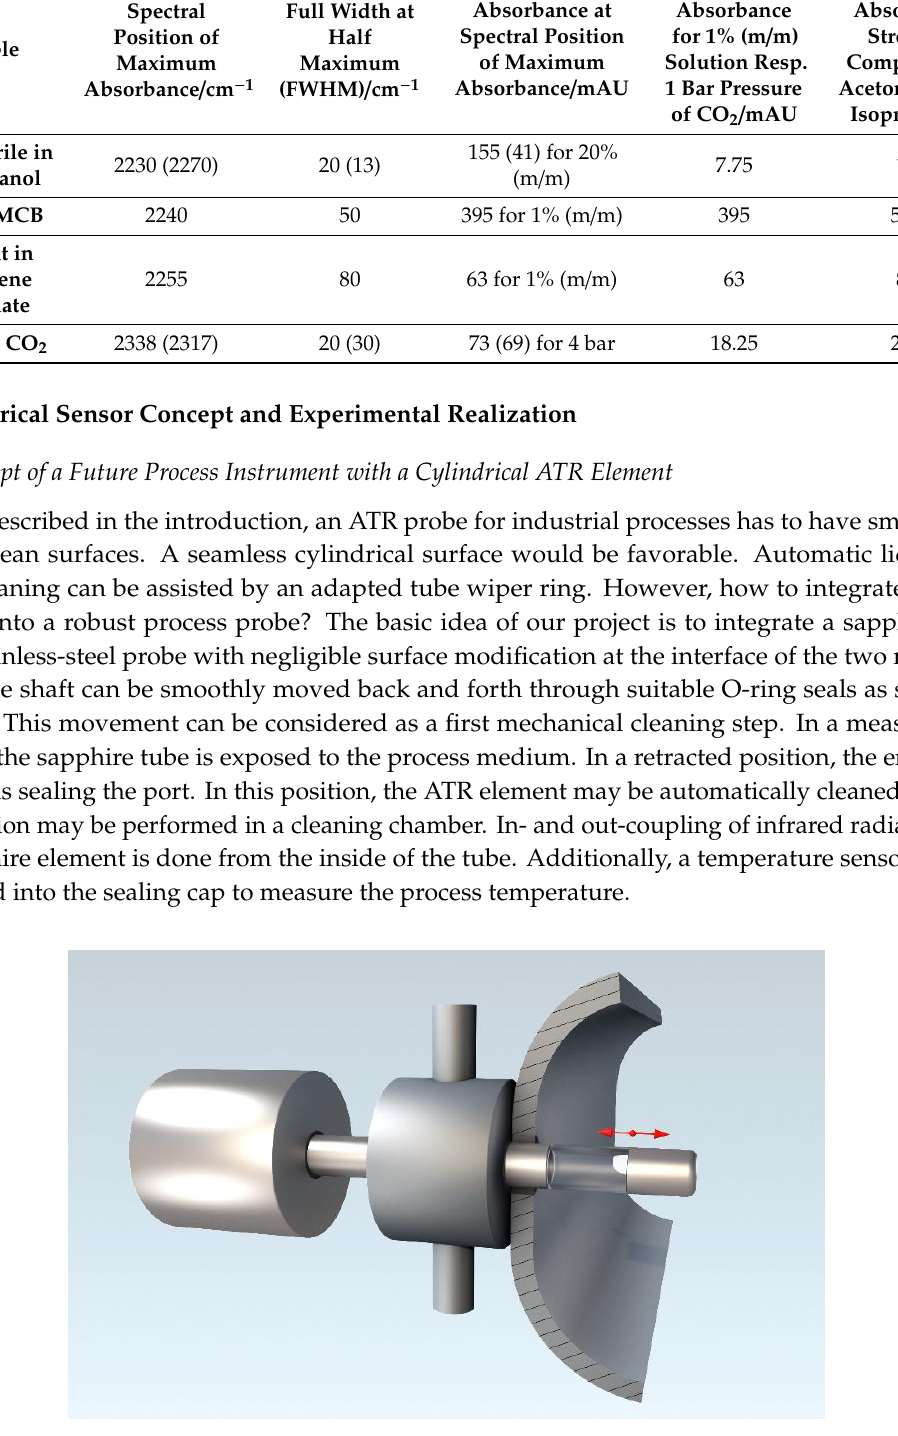
Figure 4. Concept view of a future process probe with a cylindrical ATR element. The probe consists of a tubular shaft with an integrated tubular sapphire ATR element. On one end of the shaft is the sensor control unit with signal processing and driver electronics, on the other end is a sealing cap. Between the process chamber and the control unit the shaft passes through a cleaning chamber.